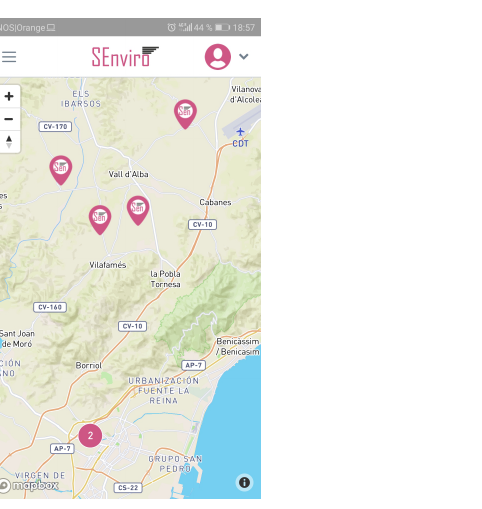
Figure 9. A screen capture of the SEnviro connect, where it shows all SEnviro nodes deployed.